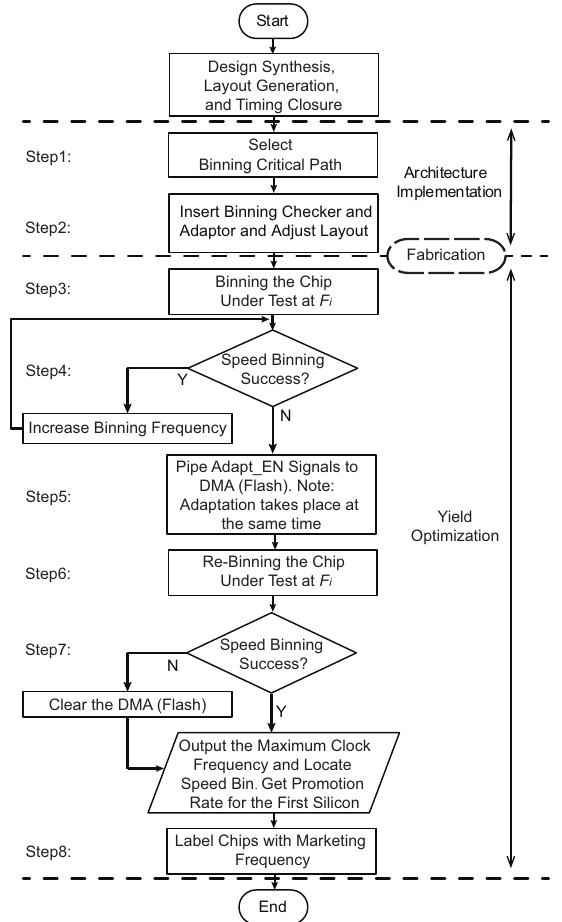
Figure 7. The proposed flow for binning and F max yield